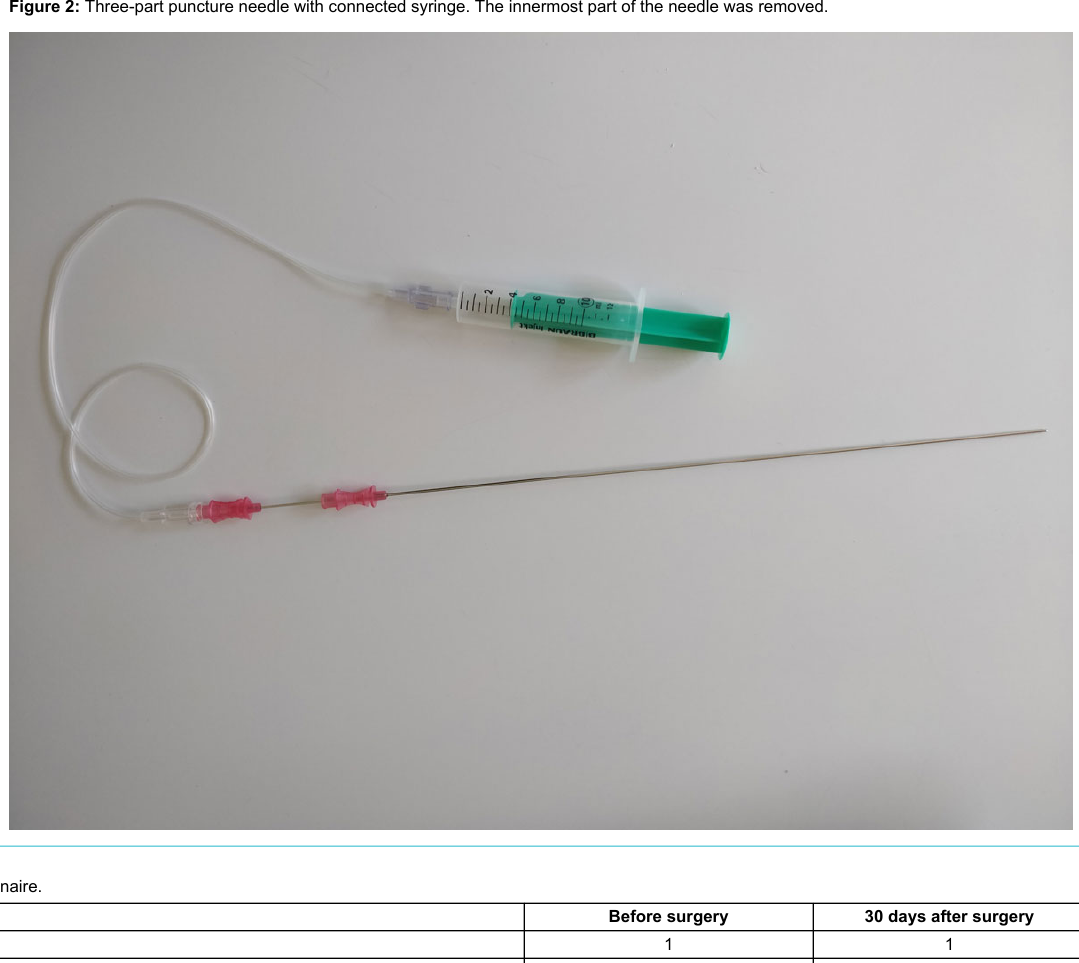
Figure 2: Three-part puncture needle with connected syringe. The innermost part of the needle was removed.